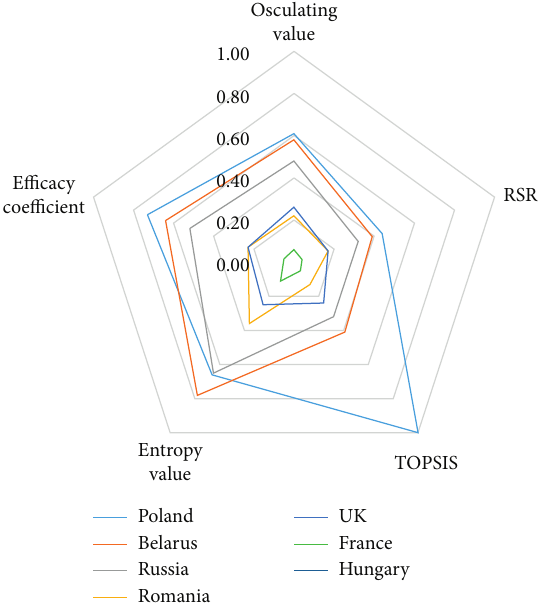
Figure 12: Matching effect picture of Chinese power companies in Europe.